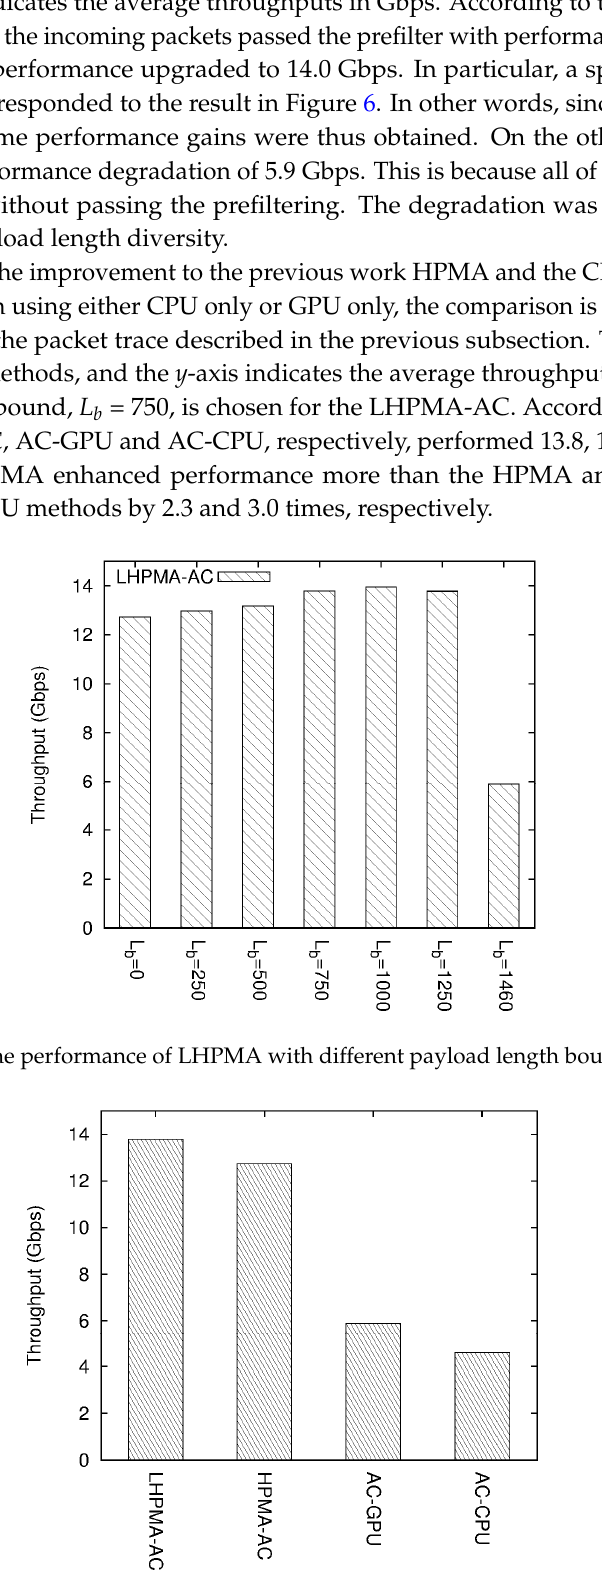
Figure 8. The performance of LHPMA and comparison with the previous methods.